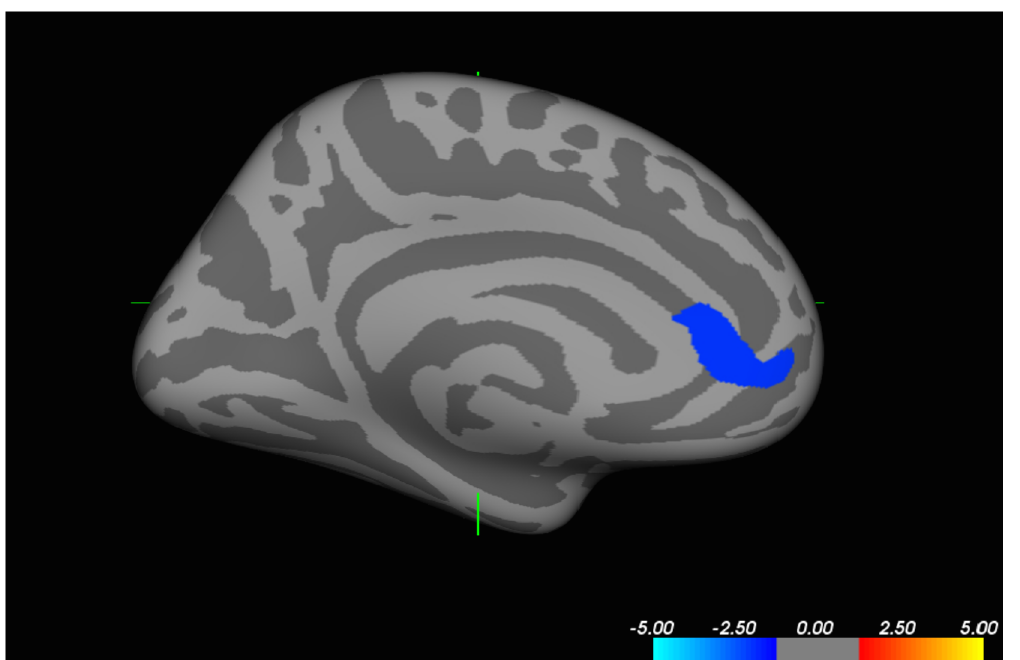
Fig 1. Whole-brain analyses testing for female patient-control differences in cortical thickness in QDEC using a vertex-level threshold of p < 0.005 and Monte-Carlo simulation generated cluster level threshold. Medial view of left hemisphere here shows control > patient differences in cortical thickness of the pregenual rostral anterior cingulate cortex extending to the medial orbitofrontal cortex.